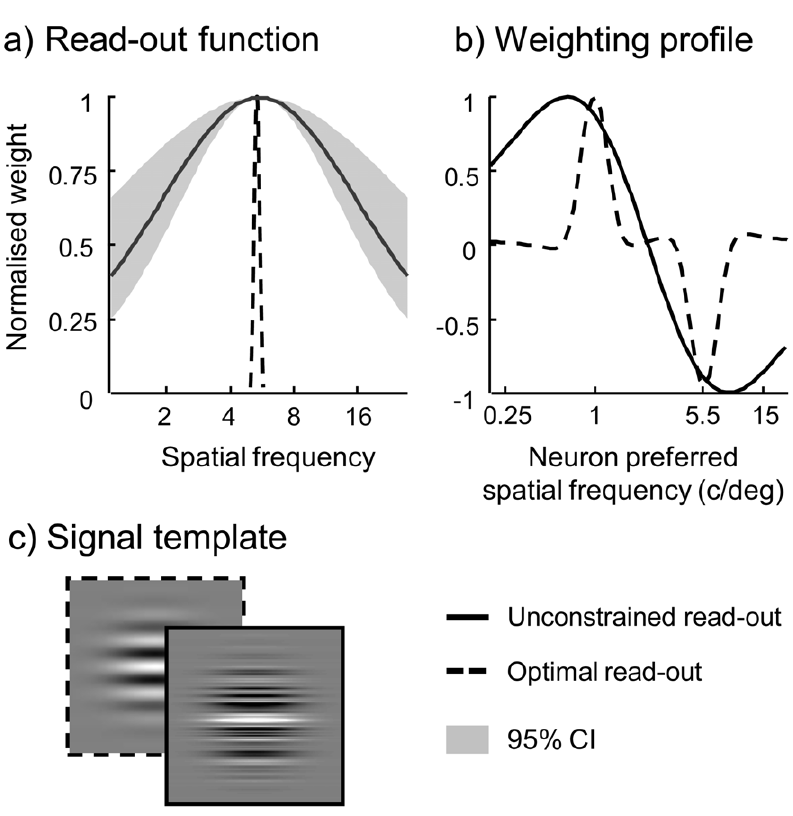
Figure 6. (a) Our population code model accounts for the perceptual bias and captures grating detectability in the presence and absence of external noise using a single set of parameters when low-precision likelihood read-out is assumed. The full line represents the best-fitting read-out function to detect or discriminate a 5.5 c/deg grating. The broken line denotes the optimal, infinitely narrow read-out function. (b) The linear weighting profile for discrimination between 1 c/deg and 5.5 c/deg that is consistent with the broad read-out function in (a). The dotted line represents the optimal weighting profile for the best-fitting model. (c) An example signal template consistent with the read-out function displayed in (a).